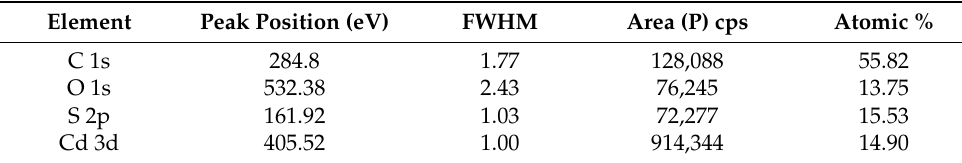
Figure 3. XPS: ( A ) Complete survey, deconvoluted spectra. ( B ) C 1s, ( C ) O 1s, ( D ) Cd 3d 5/2 , and ( E ) S 2p 3/2 . Table 1. XPS data of the GO/CdS sorbent.